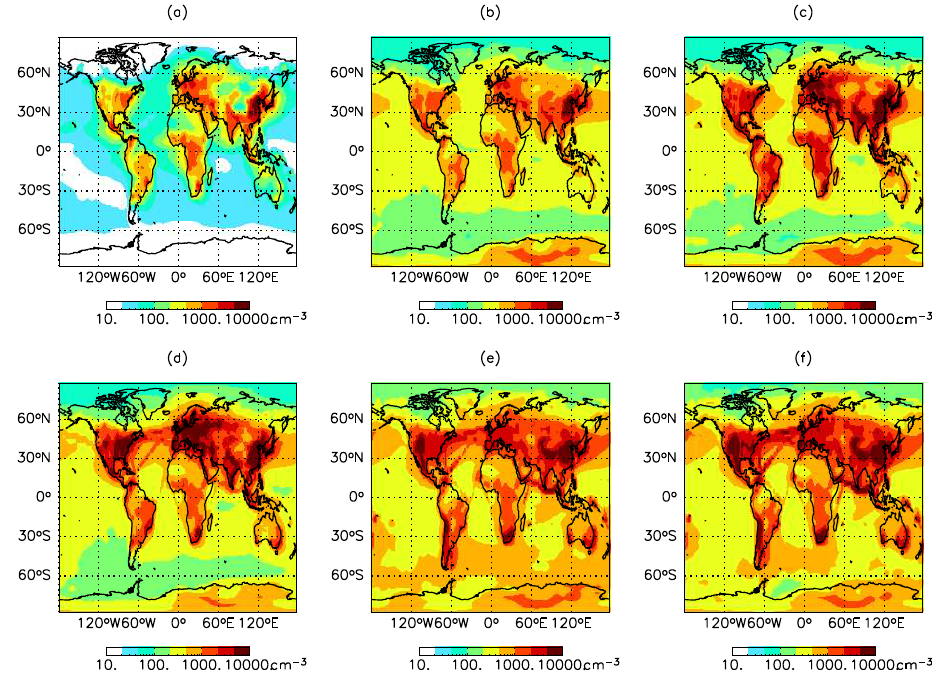
Fig. 1. Simulated surface annual mean CN (Dp > 3nm) concentrations (at ambient temperature and pressure) for the different experiments described in Table 1: (a) Primary emissions only (PRI), (b) Primary emissions and binary homogeneous nucleation (BHN), (c) BHN and increased primary EC/OC (PRICAR), (d) BHN and increased primary sulfate (PRISUL), (e) Primary emissions, BHN and activation particle formation (ACT2), (f) Primary emissions, BHN and kinetic particle formation (KIN2).